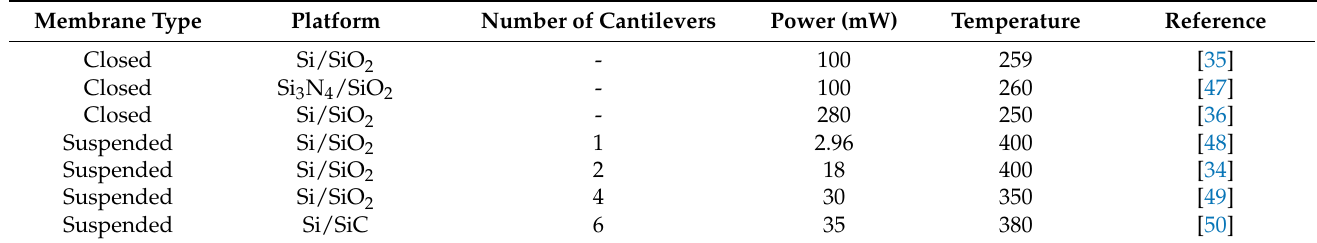
Table 2. Micro-hotplate power consumption parameters.